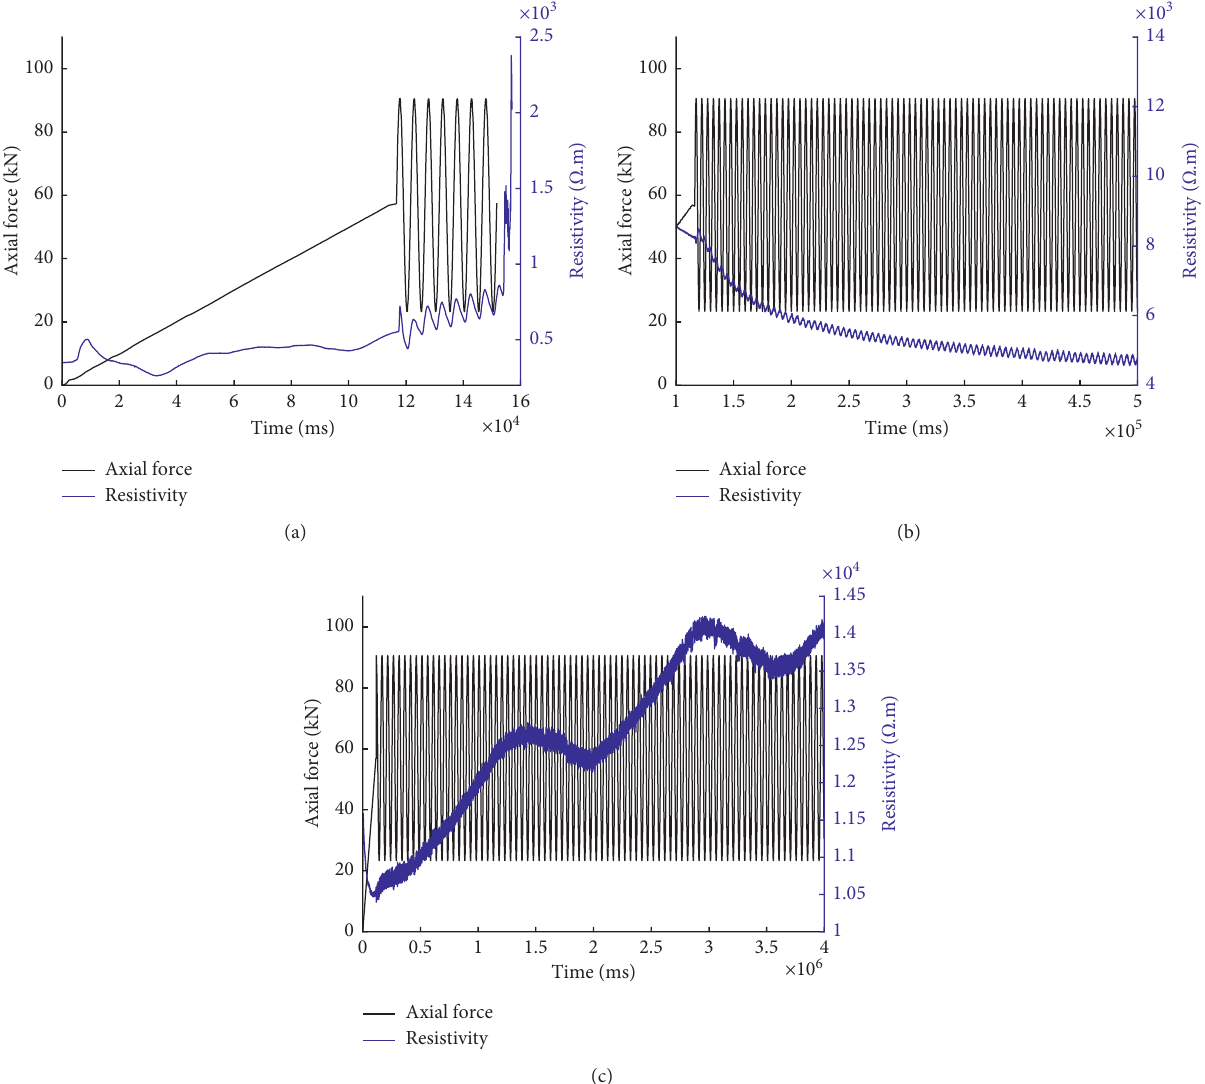
Figure 11: Resistivity evolution of sandstone under different saturation conditions. (a) In saturated state. (b) In natural state. (c) In dry